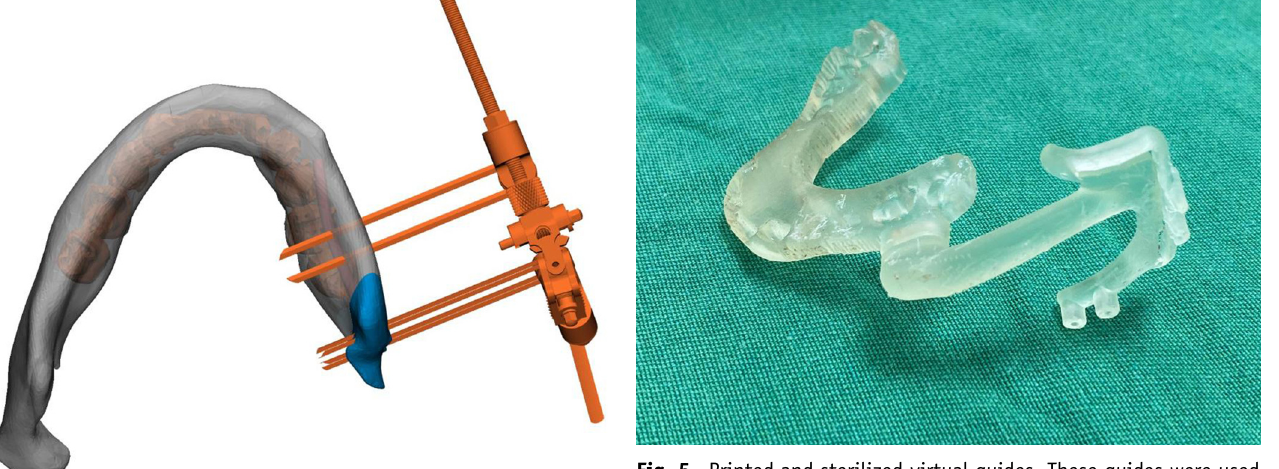
Fig. 5. Printed and sterilized virtual guides. These guides were used during the surgery.